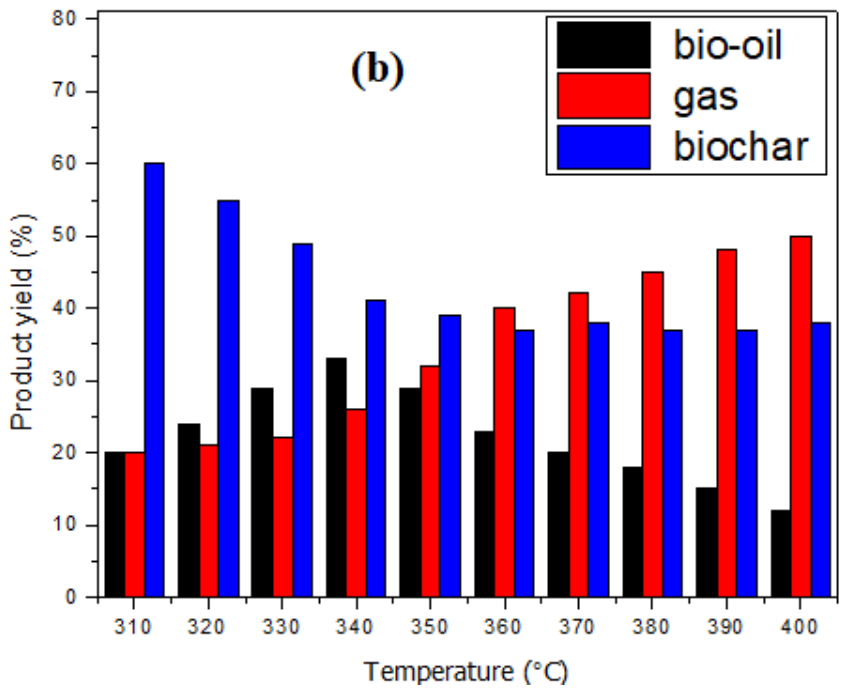
Figure 4. Optimisation of temperature ( a ) without catalyst ( b ) with catalyst .